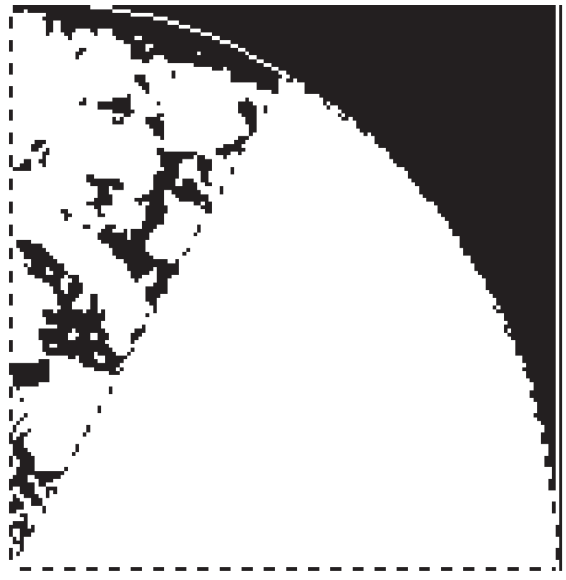
Figure 7: Extraction sector diagram of coarse